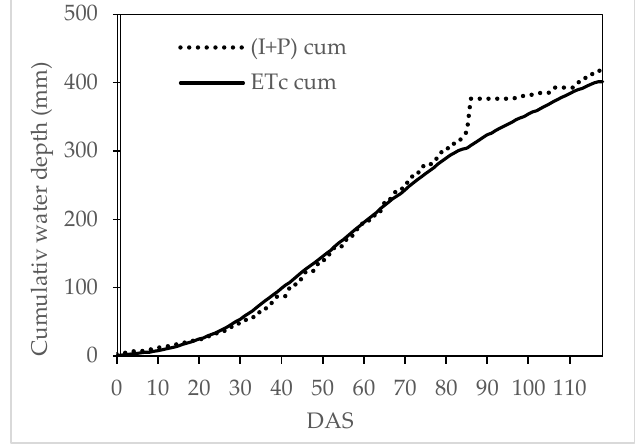
Figure 3. Daily evolution of cumulative okra crop evapotranspiration (ETc) and irrigation plus precipitation (I + P) in mm.